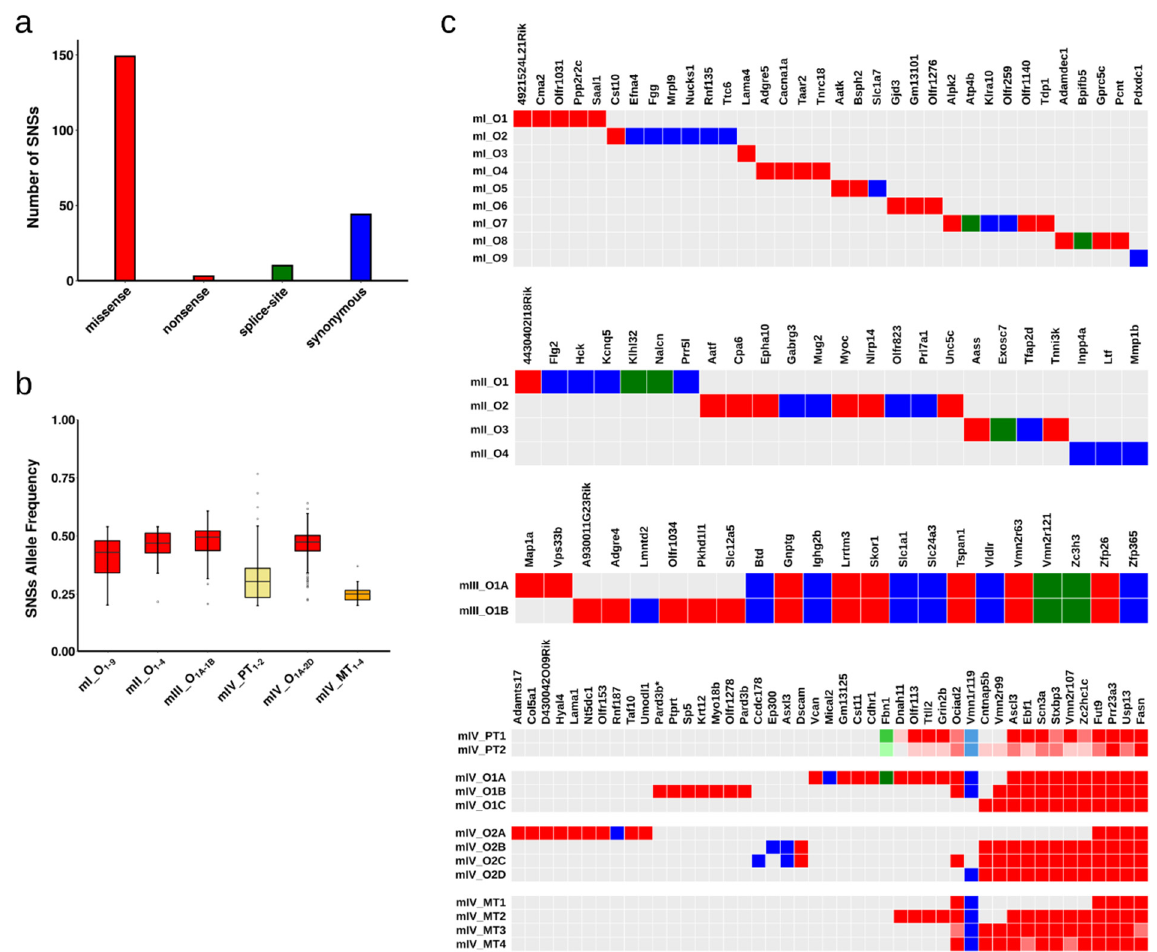
Figure 2. Types and allele frequencies of identified point mutations. ( a ) Number of single nucleotide substitutions (SNSs) within the protein-coding regions that were identified in the tumour organoids of all four mice. ( b ) Allele frequencies of coding and splicing somatic SNSs present in tumour organoids of mice I-IV and in primary and metastatic tumours of mouse IV. As expected, the average allele frequencies of the SNSs in the organoids were approximately 50% (red boxes), whereas in the primary and metastatic tumours (yellow and orange boxes, respectively) the SNS allele frequencies are lower. ( c ) Coding and splice site SNSs present in sequenced tissues and organoids. Red, blue, and green colours indicate nonsynonymous, synonymous and splice-site point mutations, respectively. For the primary and metastatic biopsies of mouse IV, SNSs with allele frequencies less than 20% or less than 10% are marked by boxes with decreased colour saturation.